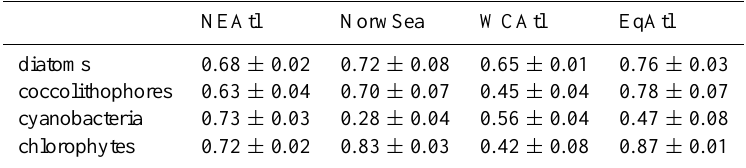
Table A5. PhytoANN’s performance with respect to the NOBM for regions and times used for training. Goodness of fit is represented by the correlation coefficient ( R -coeff) on log-transformed phyto-PFT biomass values. Results are ensemble means and 1 standard deviation from all 10 ANNs.